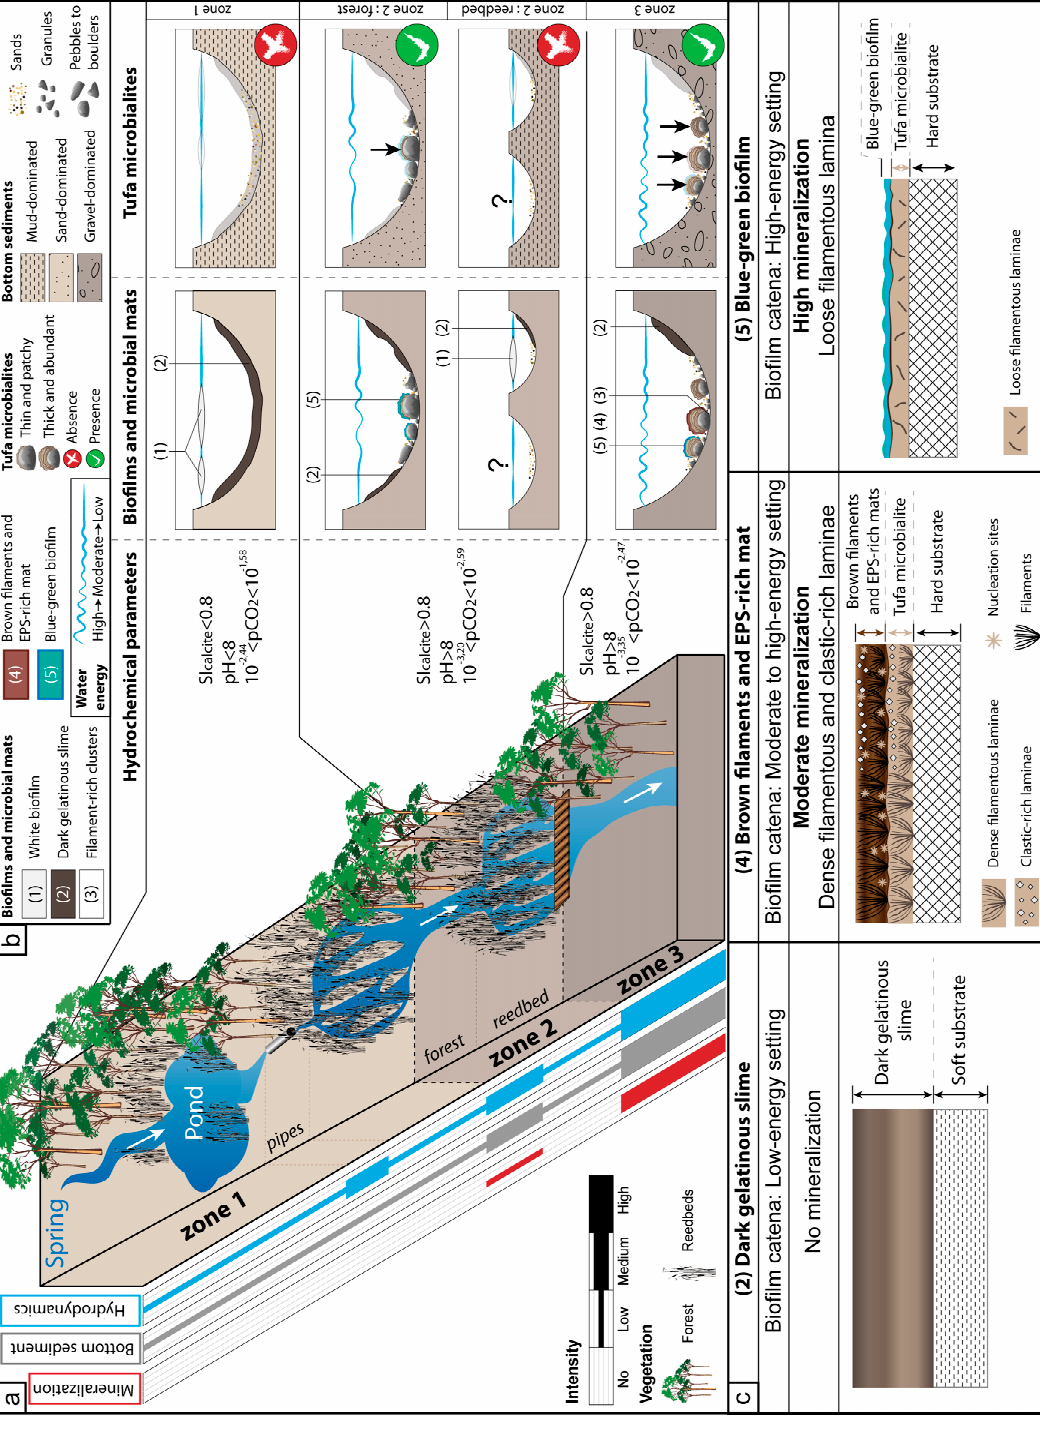
Figure 11. Diagram depicting the main biotic and abiotic characteristics: ( a ) Development of microbial mats, biofilms, and tufa microbialites along the stream showing the distribution of the bottom sediment, hydrodynamics, and the degree of mineralization; ( b ) detail of the channel bottom for each zone showing the development of living microbial mats and biofilms; note that the mineralization mainly occurred in Zone 3 and scarcely in Zone 2 as shown by the distribution of the tufa microbialites; ( c ) variations in degree of mineralization partly resulting from the thickness of the EPS (dark gelatinous slime/brown filaments EPS-rich mat) with an increase of mineralization observed when the EPS layers were thinner.